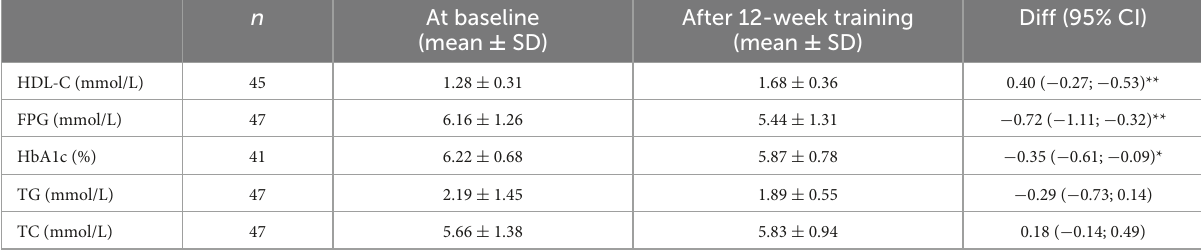
TABLE 4 Laboratory parameters at baseline and after the training program.